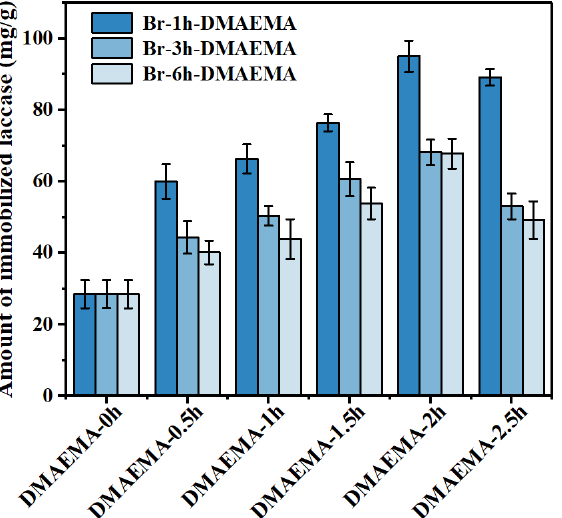
Figure 8. Amount of immobilized laccase for RC-Br-DMAEMA with different initiation and reaction times via ATRP. Table 1. Performance of the immobilized laccase using various immobilization methods and carriers.